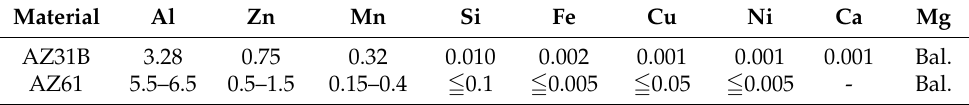
Table 1. Chemical composition of AZ31B and AZ61 magnesium alloy tubes (mass %).